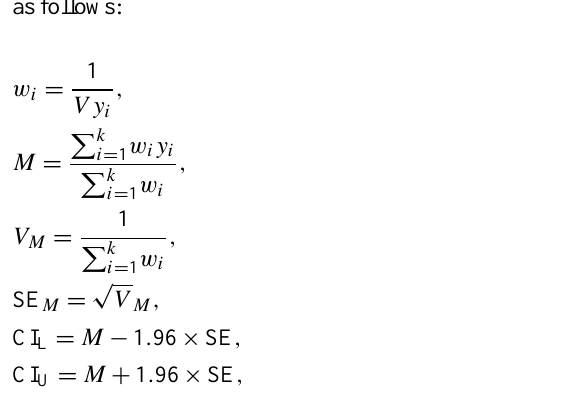
illustrating C16:0, C18:0 and C14:0 of Mediterranean lambs are presented in Fig. 1a, b and c,